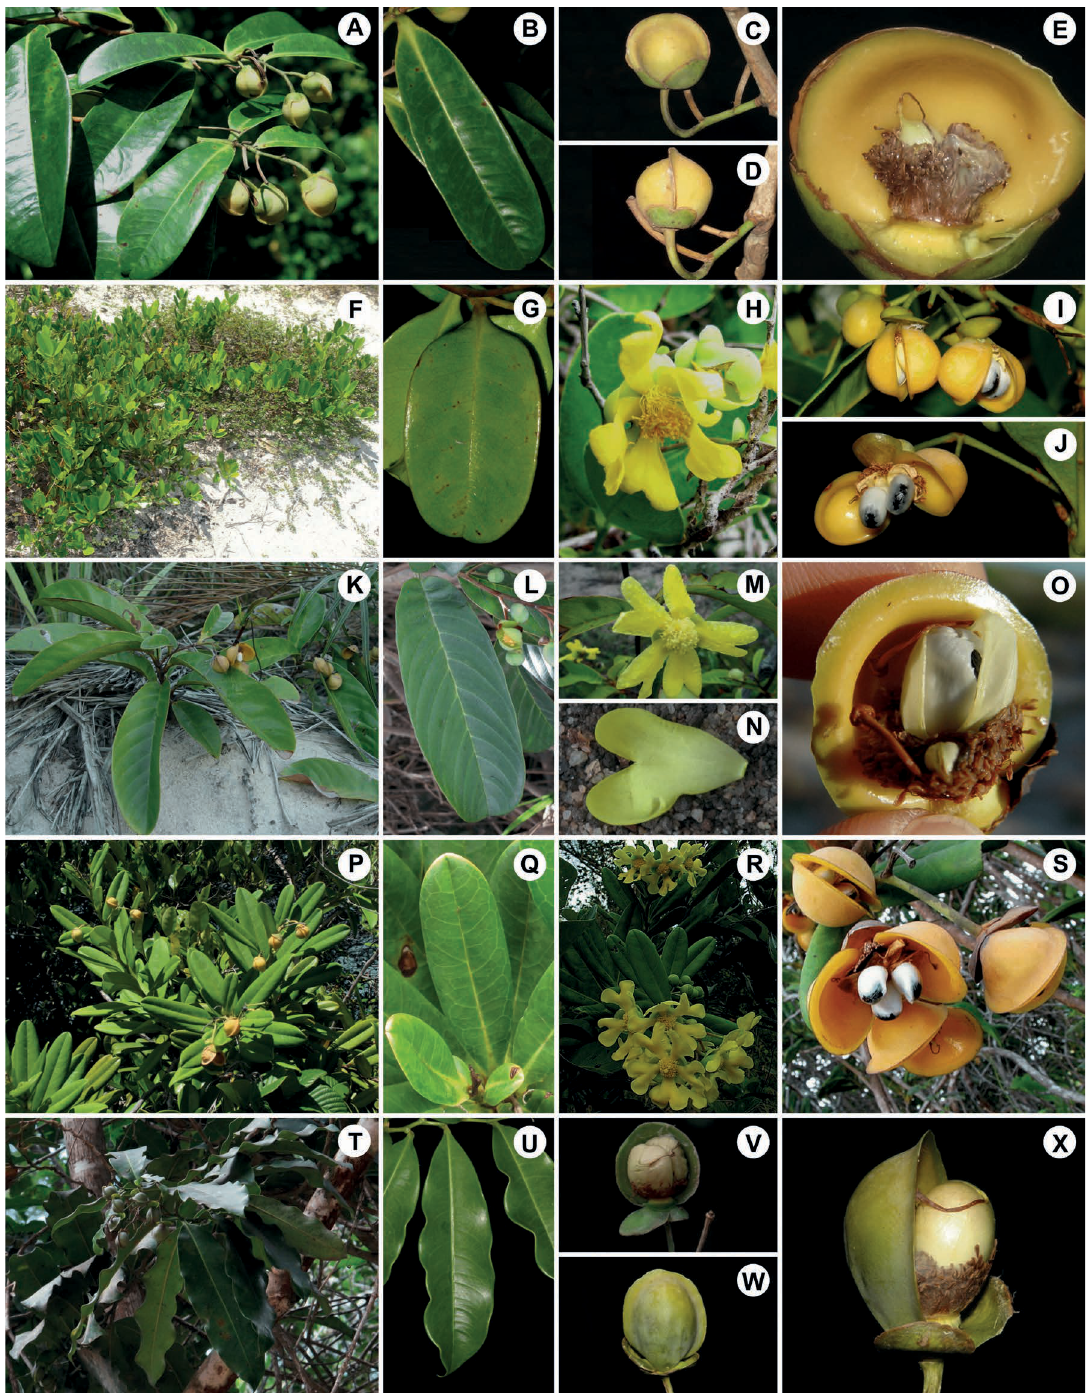
Figure 2 – Morphology of the new species and their allies: A–E, Davilla coriacea . A, branch with inflorescence; B, adaxial leaf surface; C, frontal view of persistent sepals covering the fruit; D, lateral view of persistent sepals covering the fruit; E, frontal view of persistent sepals covering stamens and ovary, with one sepal removed. F–J, Davilla flexuosa . F, ground habit; G, adaxial leaf surface; H, flower in frontal view, with petals; I–J, fruit in frontal view, with aril and seeds partially exposed. K–O, Davilla macrocarpa . K, branch with inflorescence; L, adaxial leaf surface; M, flower in frontal view, with petals; N, petal on the ground; O, frontal view of persistent sepals, with the other sepal removed and showing stamens, unfertilized ovary, seed, and aril. P–S, Davilla sessilifolia . P, branch with inflorescence; Q, adaxial leaf surface; R, inflorescence, with all flowers in simultaneous anthesis; S, fruit in frontal view, with exposed arillate seeds. T–X, Davilla undulata . T, branch with inflorescence; U, adaxial leaf surface; V, frontal view of persistent sepals covering stamens and ovary, with the other sepal removed; W, persistent sepal in lateral view; X, persistent sepal in lateral view, with the other sepal removed. Photographs by C.N. Fraga, except H by J. Nascimento Junior, M. by O.J. Pereira and R by A.V.